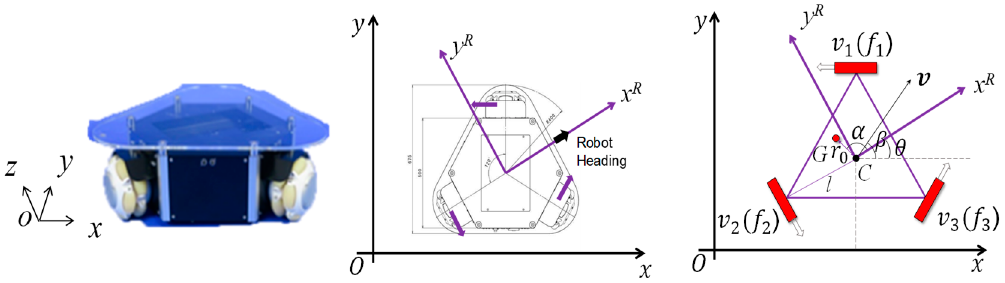
Figure 2. Usage examples of the indoor carrier robot: ( a ) Carrying books; ( b ) Carrying a package.